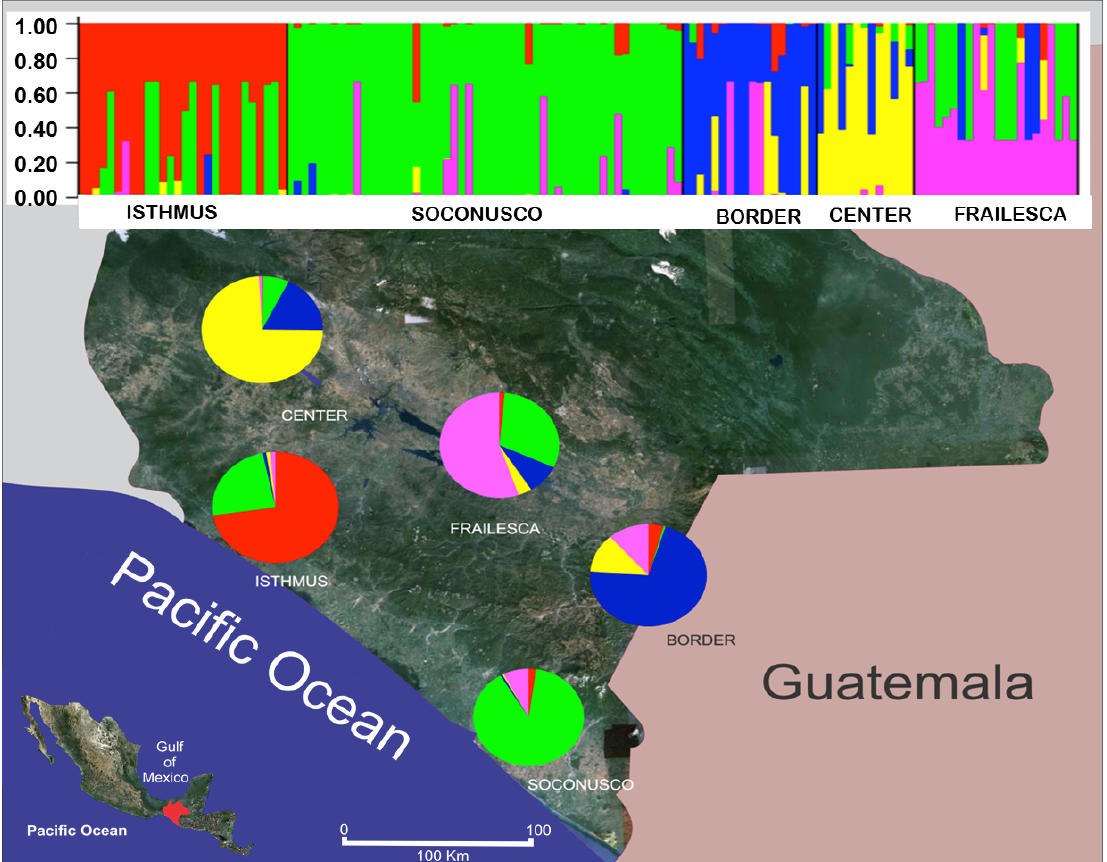
Figure 3. Genetic structure of five populations of J. curcas of Chiapas, Mexico. Obtained with the software Structure © 2.3.2. with 30,000 burn-in, 50,000 replications after burn-in and 10 runs for each K (K 1–9). Ancestry model: GENSBACK = 3, MIGPRIOR =